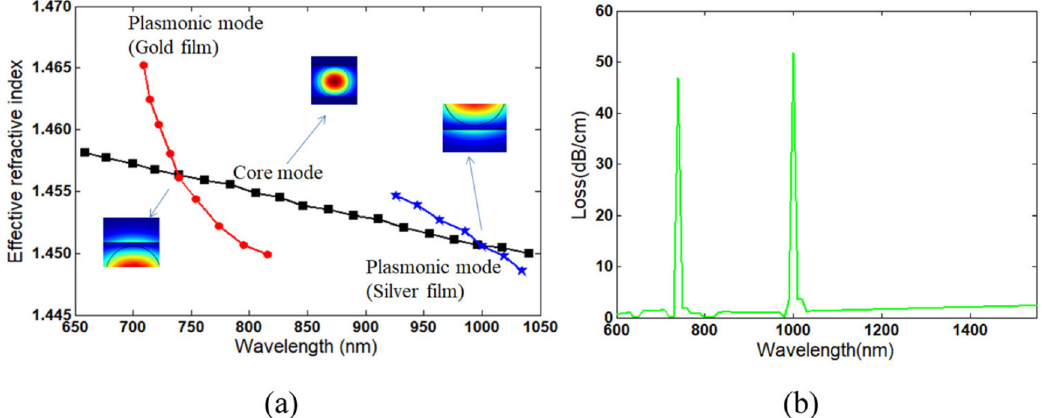
Figure 39. Point sensor. ( a ) Effective index as a function of wavelength, and ( b ) confinement loss spectra. Reprinted with permission from ref. [203]. Copyright 2021 Taylor & Francis .